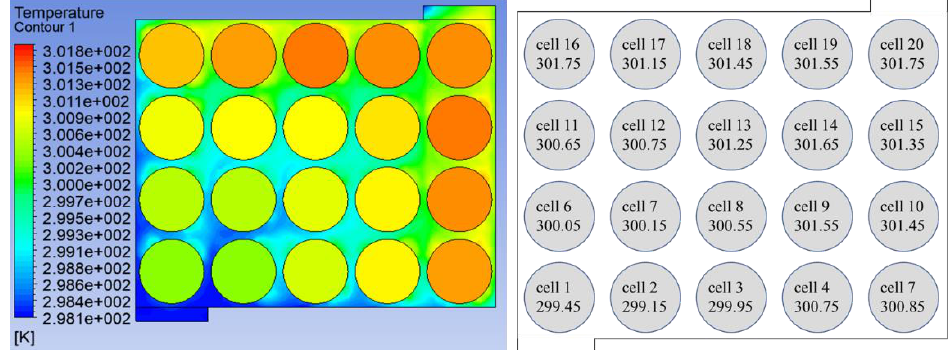
Figure 22. Comparison between the simulation and experimental results for scheme 13 (simulation on the left and experiment on the